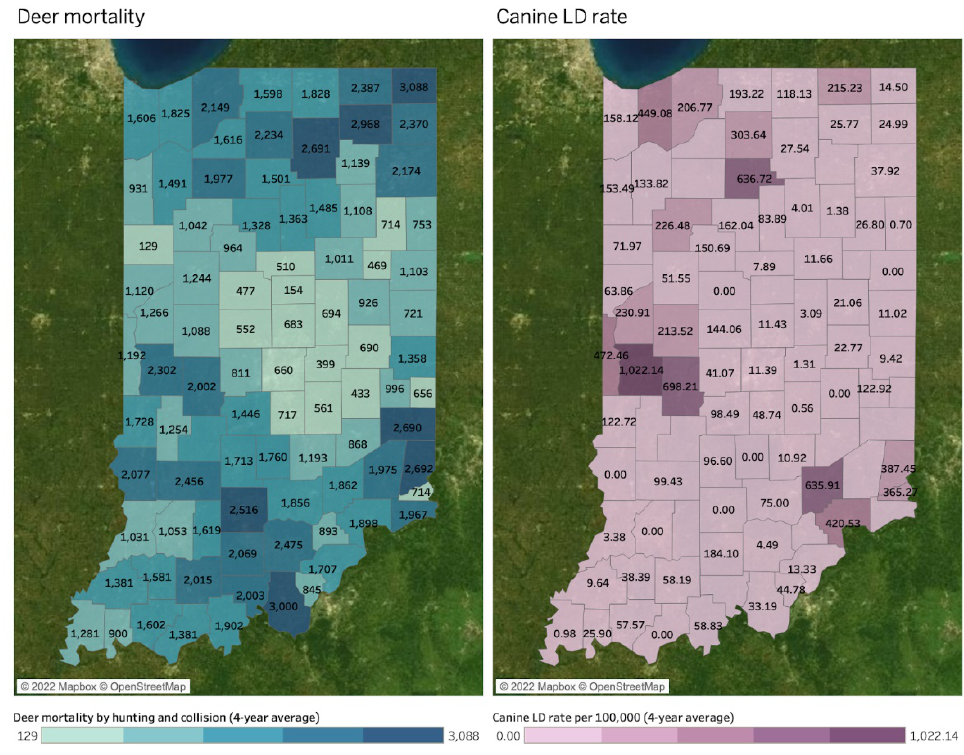
Figure 8. Deer mortality and canine LD rate by county (4-year average between 2017 and 2020).